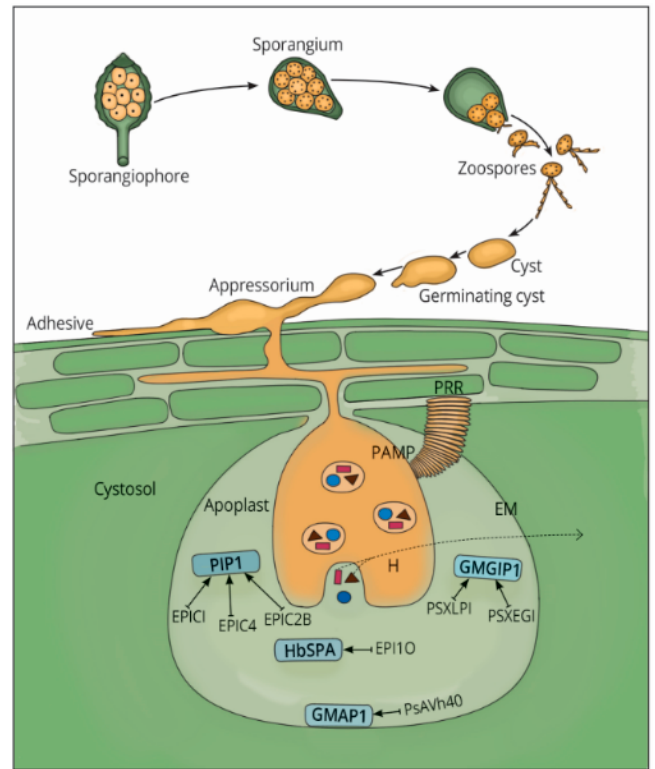
Figure 1. Proposed model of Phytophthora species infection process and the apoplastic effectors inhibiting plant proteases. The dispersal phase starts with multinucleate sporangium which releases zoospores which encyst on the plant host then germinate to swelling at the end of the germ tube which attach to the host cell using adhesive. Thereafter, it penetrates the host cell using the appressorium to form intercellular hyphae which is commonly known as infection vesicle that grows between host cells to form a haustorium (H) that invaginates the host cell membrane (EM) to secrete apoplatic effectors (in blue) RxLRs (purple) and CRNs (brown). Apoplastic effectors inhibit ( → ) key plant protease in bold; Phytophthora Inhibited Protease (PIP1), Hevea brasiliensis serine protease (HbSPA), soybean aspartic protease(GMAP1) and soybean glucanase (GMGIP1). The conserved PAMP is perceived by the host plant recognition receptor (PRR) leading to the activation of the host’s first line of defense.